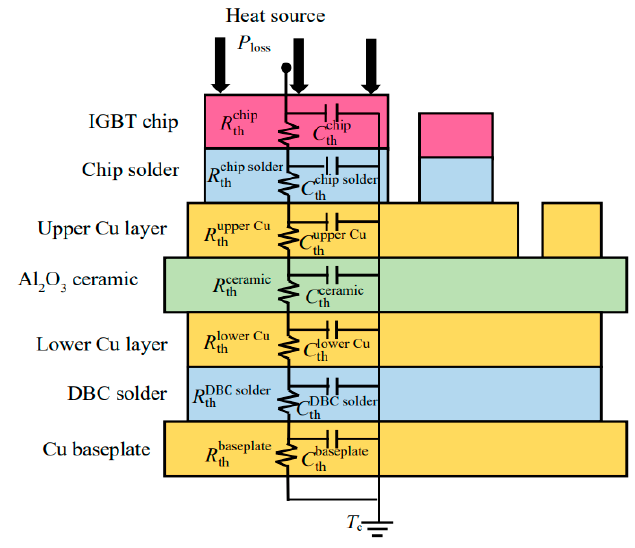
Figure 3. Cauer thermal network model of the IGBT module.